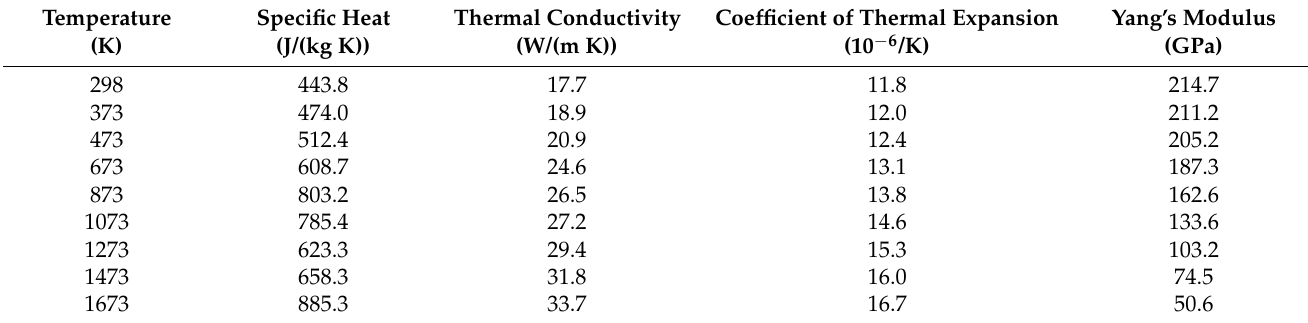
Table 3. Welding parameters.